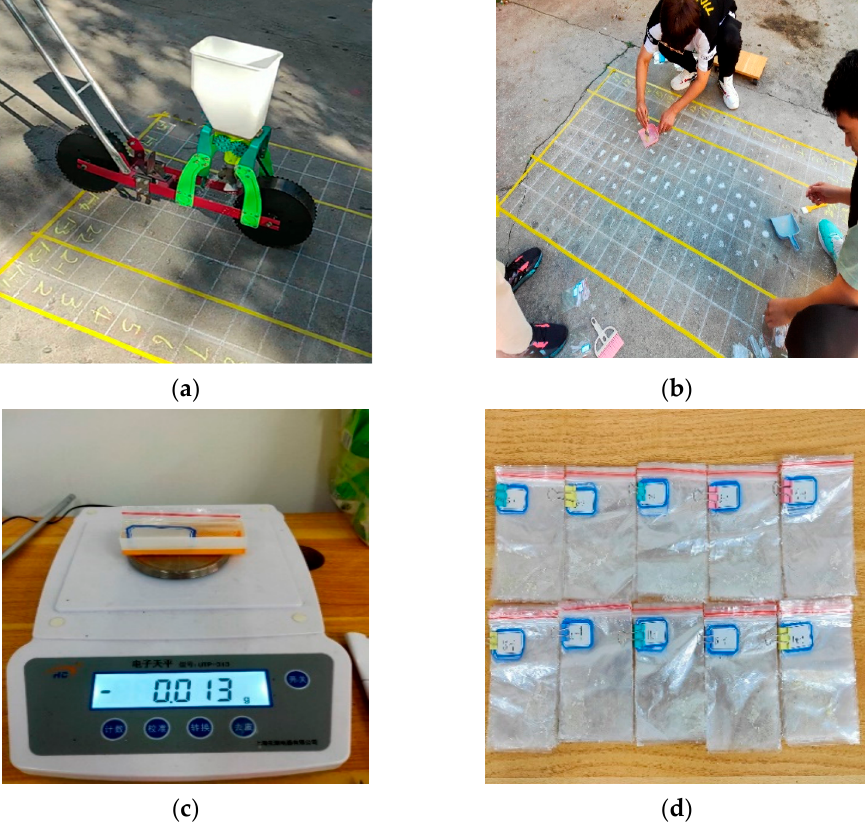
Figure 12. Experimental procedure. ( a ) Testing device, ( b ) fertilizer collection, ( c ) weighing process, ( d ) fertilizer collection bags.